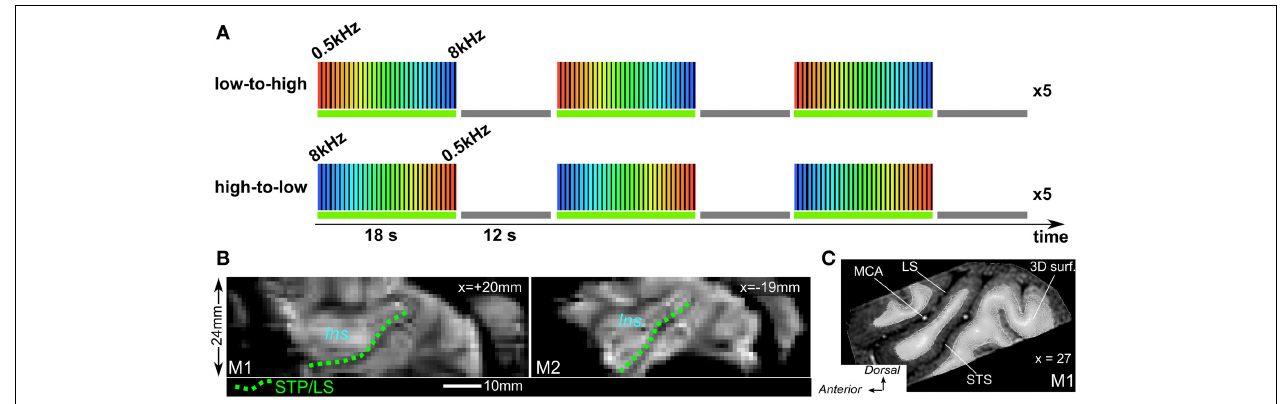
FIGURE 2 | Phase-encoded fMRI design and mean image of times series. (A) Both run types were alternated with either low-to-high (top) or hig-to-low frequency progression and “ON” block was always followed by a 12s. “OFF” block (baseline). (B) Sagittal view from mean image of time series for both